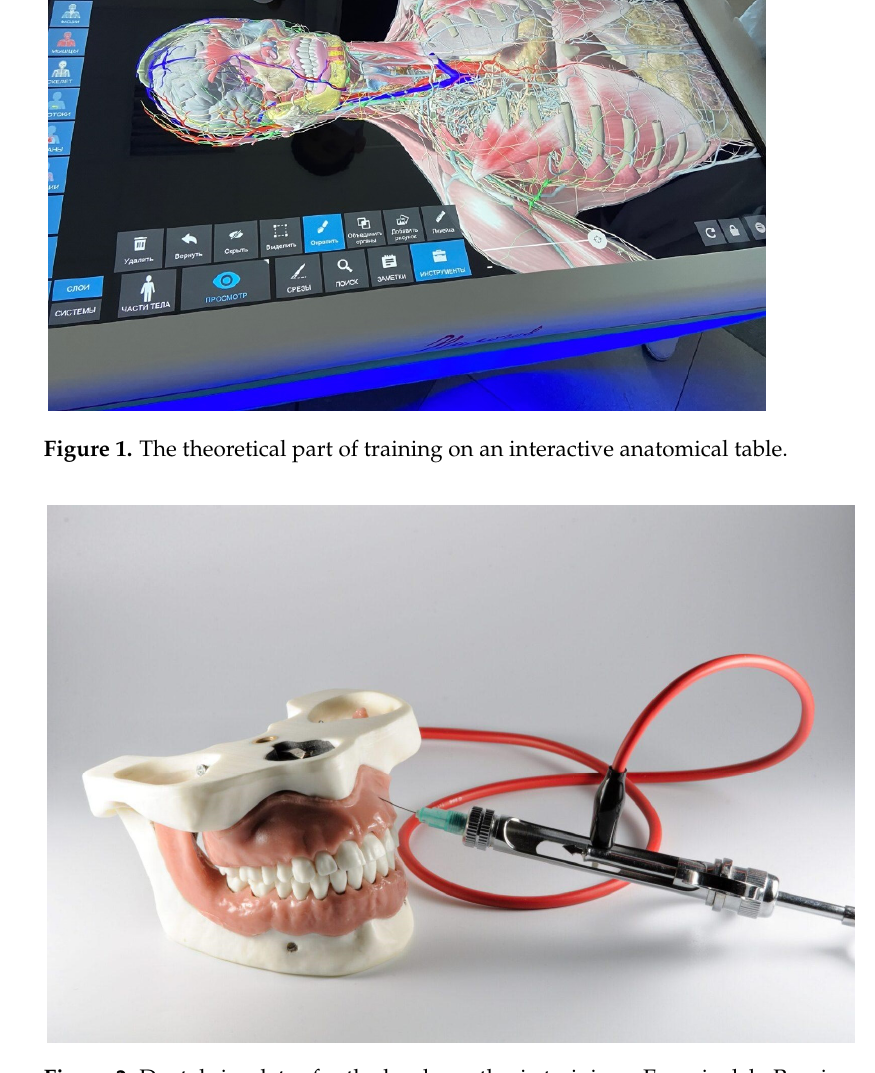
Figure 2. Dental simulator for the local anesthesia trainings, Energiyalab, Russia.